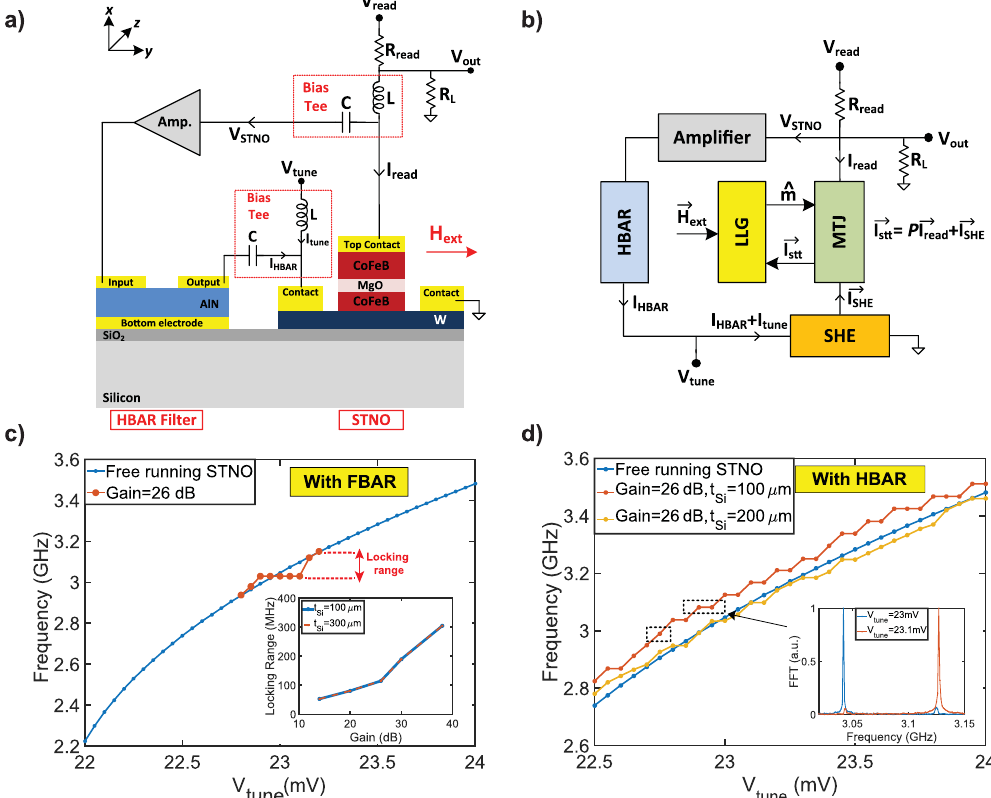
Figure 4. Implementation of MASH oscillator with current feedback: ( a ) A three-terminal MTJ and a 2-port HBAR are fabricated on the same silicon substrate, and coupled to each other with the current feedback. ( b ) Modular modeling of transport, magnetization, and resonator dynamics. ( c ) Locking range versus amplifier gain for two different substrate thicknesses (100 μ m and 200 μ m) simulated with an FBAR. The thicker substrate ( t Si = 200 μ m) does not affect the gain needed for the locking. ( d ) Tunability can be achieved with 22 MHz or 43 MHz steps depending on the substrate thickness ( t Si ) using the same amplifier gain by locking the nearest high Q peaks of the